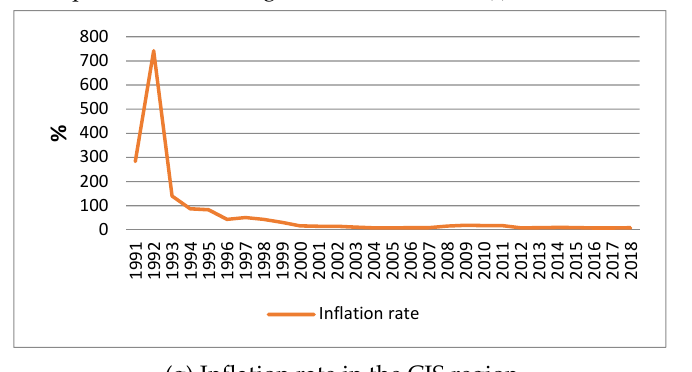
Figure 3. Trends of variables, 1993–2018, [4,36] .